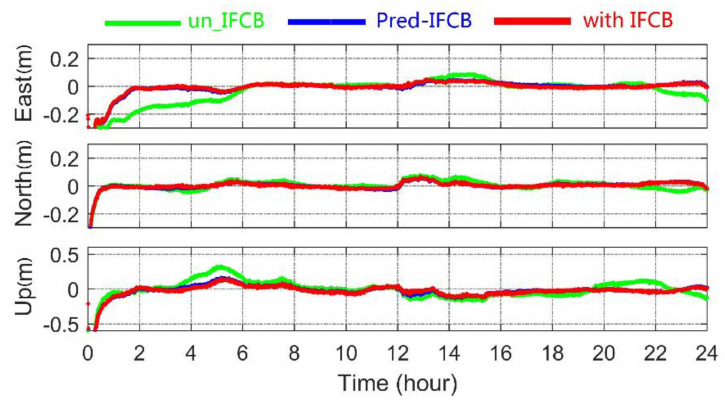
Figure 11. Kinematic PPP positioning errors for three different directions at